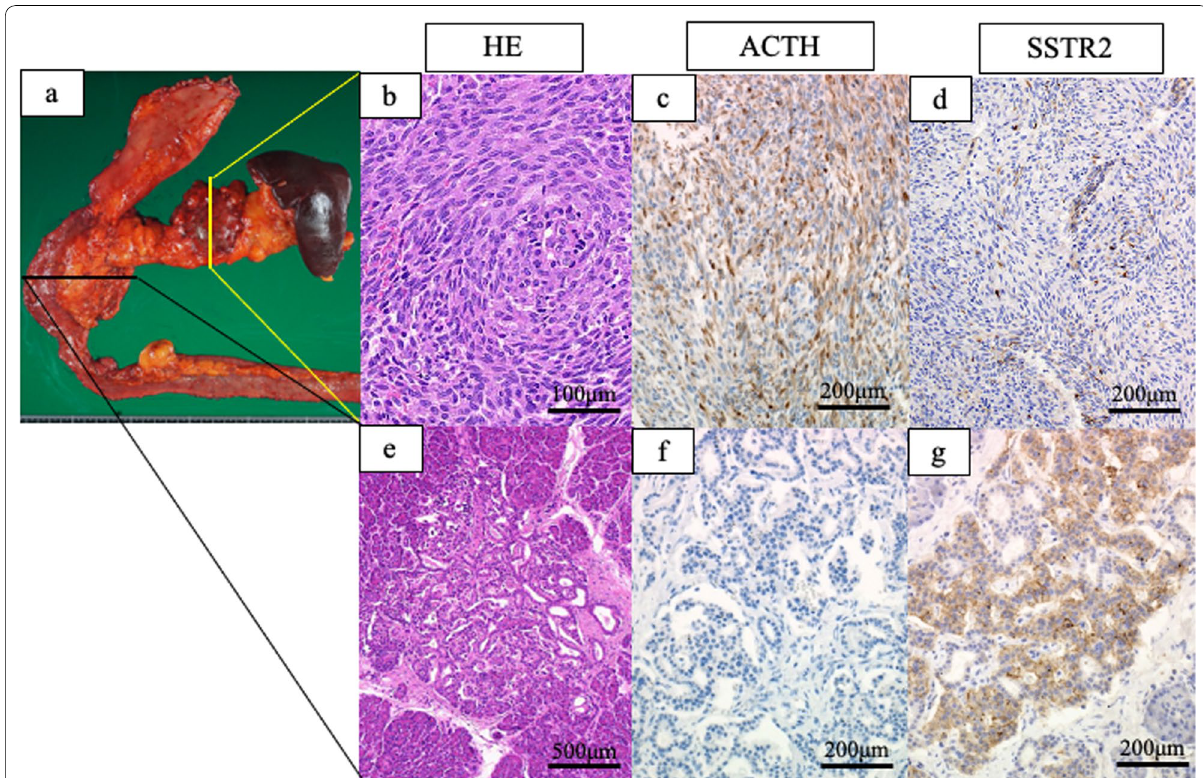
Fig. 7 Histopathological examination. a The tumor located in the pancreatic tail is 6 cm in diameter. b The tumor located in the pancreatic tail contains rosette-like components when viewed microscopically. c Immunohistochemical examination shows ACTH positivity. d SSTR2 expression in the tumor is weakly positive. e Multiple lesions of islet of Langerhans cell hyperplasia are seen in the head of the pancreas. The maximal size of the islets is 2 mm. f Immunoreactivity for ACTH is negative. g The tumor cells are positive for SSTR2. HE hematoxylin and eosin stain, ACTH adrenocorticotropic hormone, SSTR somatostatin